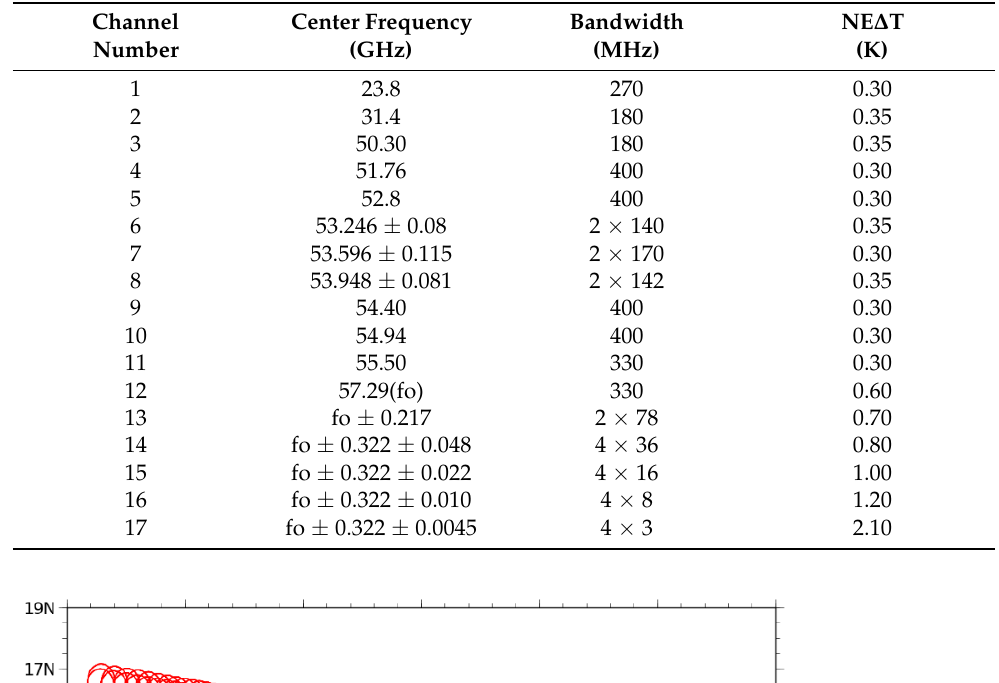
Table 2. MWTS-III instrument characteristics.